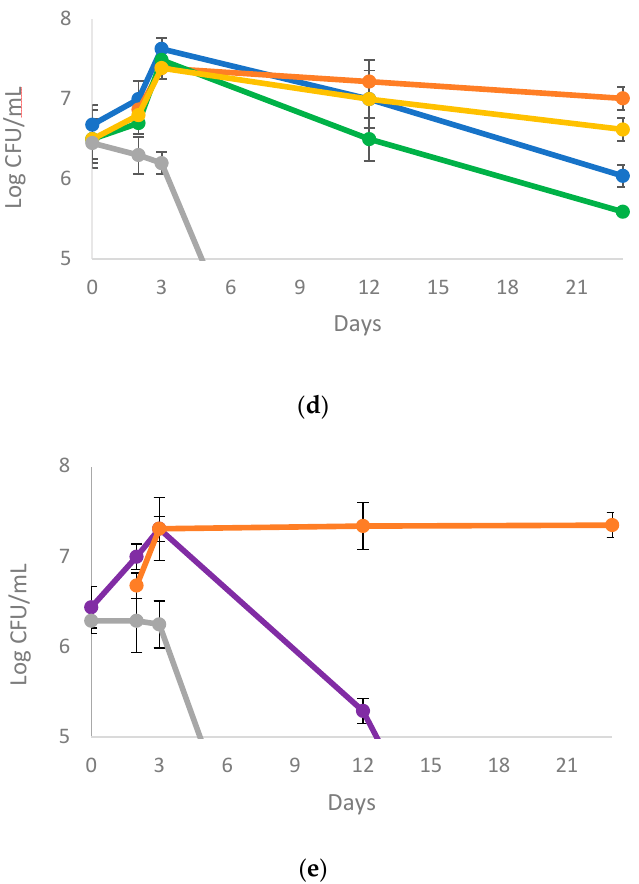
Days Days ( e ) ( e ) Figure 1. Yeast growth kinetics for S. cerevisiae ( ) in pure inoculation ( a ); in sequential fermen- Figure 1. Yeast growth kinetics for S. cerevisiae ( ) in pure inoculation ( a ); in sequential fermenta- Figure 1. Yeast growth kinetics for S. cerevisiae ( ) in pure inoculation ( a ); in sequential fermen- Figure 1. Yeast growth kinetics for S. cerevisiae ( ) in pure inoculation ( a ); in sequential fermen- Figure 1. Yeast growth kinetics for S. cerevisiae in pure inoculation ( a ); in sequential fer- Figure 1. Yeast growth kinetics for S. cerevisiae ( ) in pure inoculation ( a ); in sequential fermen- Figure 1. Yeast growth kinetics for S. cerevisiae in pure inoculation ( a ); in sequential fer- Figure 1. Yeast growth kinetics for S. cerevisiae in pure inoculation ( a ); in sequential fer- tation with S. bombicola ( ) ( b ) and with L. thermotolerans ( ) ( c ). Sequential fermentation tion with S. bombicola ( ) ( b ) and with L. thermotolerans ( tation with S. bombicola ( ) ( b ) and with L. thermotolerans ( ) ( c ). Sequential fermentation tation with S. bombicola ( ) ( b ) and with L. thermotolerans ( ) ( c ). Sequential fermentation Figure 1. Yeast growth kinetics for S. cerevisiae ( ) in pure inoculation ( a ); in sequential fermen- Figure 1. Yeast growth kinetics for S. cerevisiae ( ) in pure inoculation ( a ); in sequential fermen- mentation with S. bombicola ( b ) and with L. thermotolerans ( c ). Sequential fer- tation with S. bombicola ( ) ( b ) and with L. thermotolerans ( ) ( c ). Sequential fermentation mentation with S. bombicola ( b ) and with L. thermotolerans ( c ). Sequential fer- mentation with S. bombicola ( b ) and with L. thermotolerans ( c ). Sequential fer- with S. bombicola ( ) L. thermotolerans ( ) and T. delbrueckii ( ) ( d ); Spontaneous fermen- with S. bombicola ( ) L. thermotolerans ( ) and T. delbrueckii ( ) ( d ); Spontaneous fermen- with S. bombicola ( ) L. thermotolerans ( ) and T. delbrueckii ( ) ( d ); Spontaneous fermen- tation with S. bombicola ( ) ( b ) and with L. thermotolerans ( ) ( c ). Sequential fermentation tation with S. bombicola ( ) ( b ) and with L. thermotolerans ( ) ( c ). Sequential fermentation mentation with S. bombicola L. thermotolerans and T. delbrueckii ( d ); with S. bombicola ( ) L. thermotolerans ( ) and T. delbrueckii ( ) ( d ); Spontaneous fermen- mentation with S. bombicola L. thermotolerans and T. delbrueckii ( d ); mentation with S. bombicola L. thermotolerans and T. delbrueckii ( d ); tation with evolution of whole wild non- Saccharomyces yeasts ( ) (excluded apiculate yeasts) ( e ). tation with evolution of whole wild non- Saccharomyces yeasts ( ) (excluded apiculate yeasts) ( e ). tation with evolution of whole wild non- Saccharomyces yeasts ( ) (excluded apiculate yeasts) ( e ). with S. bombicola ( ) L. thermotolerans ( ) and T. delbrueckii ( ) ( d ); Spontaneous fermen- with evolution of whole wild non- Saccharomyces yeasts ( Spontaneous fermentation with evolution of whole wild non- Saccharomyces yeasts (ex- with S. bombicola ( ) L. thermotolerans ( ) and T. delbrueckii ( ) ( d ); Spontaneous fermen- tation with evolution of whole wild non- Saccharomyces yeasts ( ) (excluded apiculate yeasts) ( e ). (ex- In all figures apiculate yeasts ( ). In all figures apiculate yeasts ( ). In all figures apiculate yeasts ( ). tation with evolution of whole wild non- Saccharomyces yeasts ( ) (excluded apiculate yeasts) ( e ). tation with evolution of whole wild non- Saccharomyces yeasts ( ) (excluded apiculate yeasts) ( e ). . In all figures apiculate yeasts ( ). In all figures apiculate yeasts ( ). In all figures apiculate yeasts (